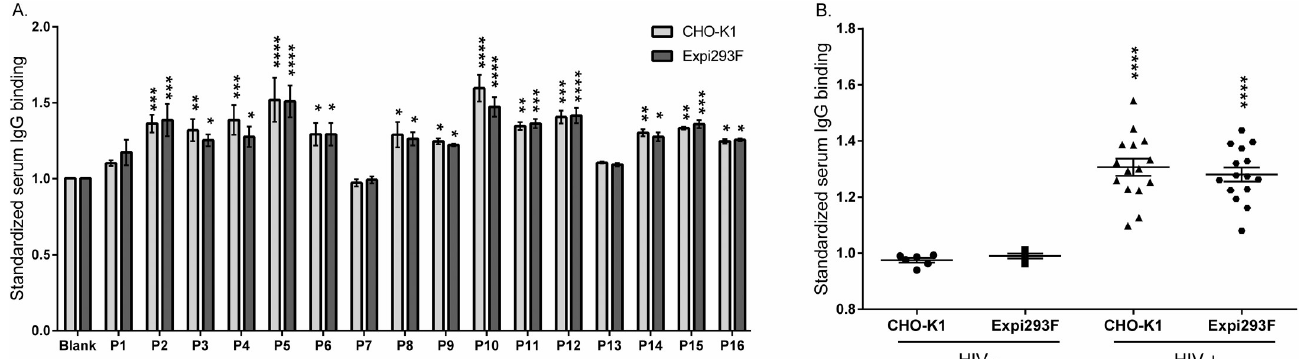
Fig 7. IgG binding from HIV+ patient plasma to gp145 produced in CHO-K1 and Expi293F cells. The recombinant protein gp145, produced in either CHO-K1 or Expi293F cells, was tested for its potential to bind antibodies found in HIV+ patients using an ELISA assay. ( A ) Plasma samples from 16 HIV + patients, P1-P16, (1:10,000 dilution) were incubated in 96-well plates coated with gp145 samples produced in two different cell lines (0.5 μ g/mL per well). Binding was detected with an anti-human IgG HRP-conjugated antibody. Absorbance was read at 490 nm and standardized against the blank. Values significantly different from the blank (represented by asterisks) were considered reactive. Statistical significance was calculated using a Two-Way ANOVA. � p < 0.05, �� p < 0.01, ��� p < 0.001, ���� p < 0.0001 ( B ) HIV+ samples were compared with HIV uninfected samples using One-Way ANOVA. Significant differences (represented by asterisks) were found between the two groups but not between immunogens. ���� p <